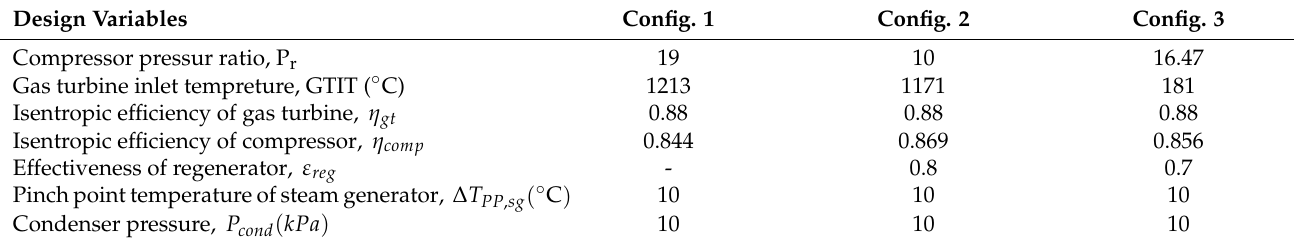
Table 16. Design variables of configurations shown in Figures 1–3 in the optimum case.